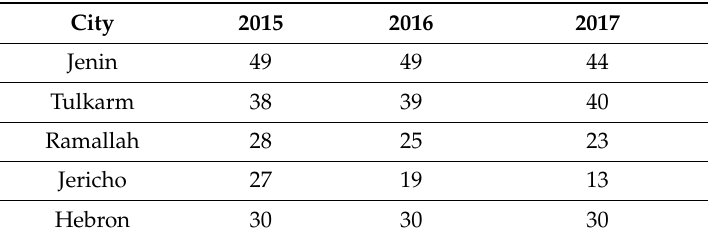
Table 16. Water losses (WL)